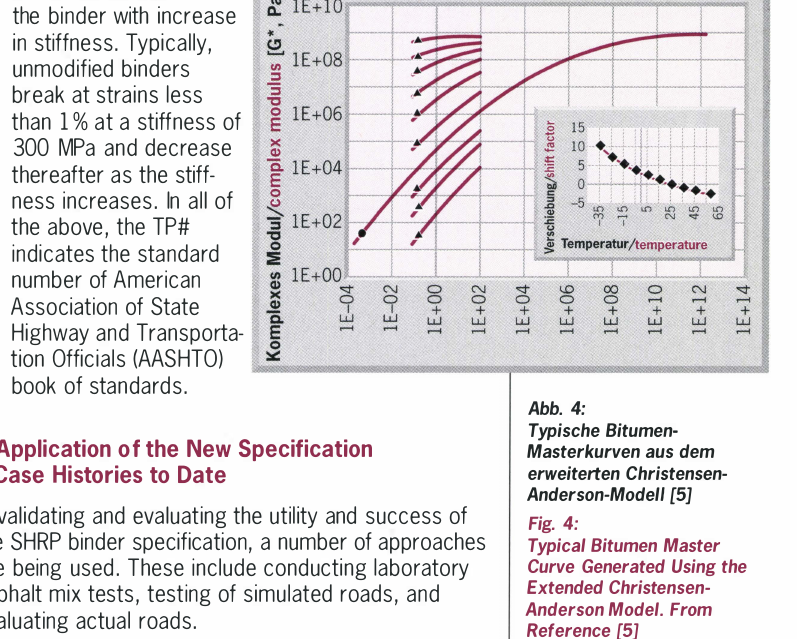
Fig. 4: Typical Bitumen Master Curve Generated Using the Extended Christensen­ Anderson Model. From Reference